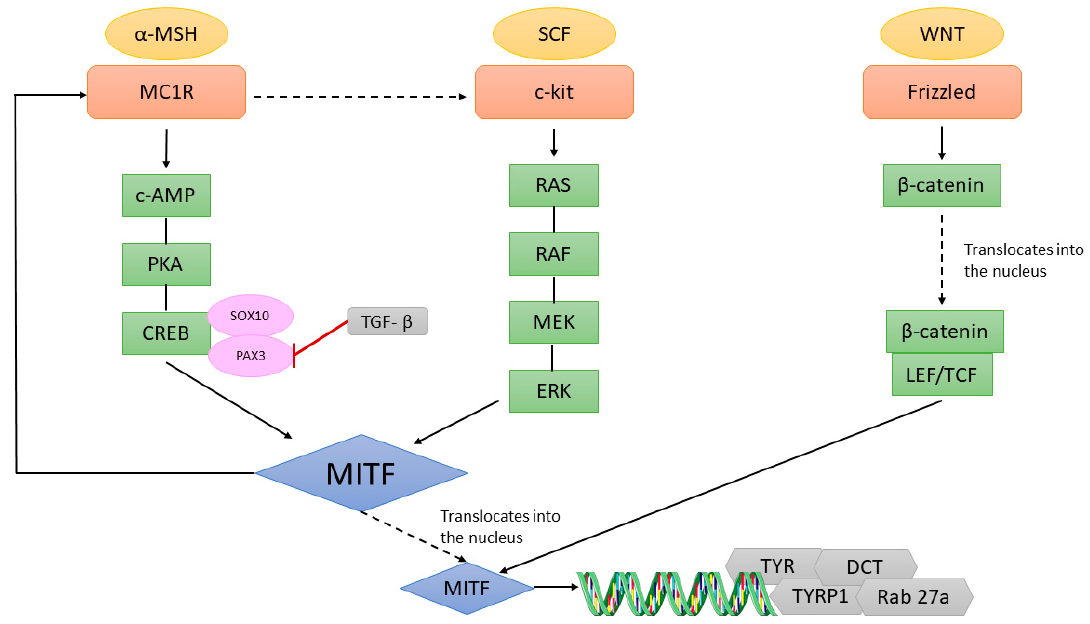
Figure 3. Schematic representation of the pathways that lead to MITF activation. α -MSH = α -melanocyte-stimulating hormone, MC1R = melanocortin 1 receptor, c-AMP = cyclin adenosine monophosphate, PKA = protein kinase A, CREB = cAMP response element, SOX10 = SRY-Box transcription factor 10, PAX3 = paired box 3, SCF = stem cell factor, ERK = extracellular signal-regulated kinase, LEF/TCF = lymphoid enhancer-binding factor/T cell factor, MITF = microphthalmia-associated transcription factor, TYR = tyrosinase, DCT = dopachrome tautomerase, TYRP-1 = tyrosinase-related protein 1.